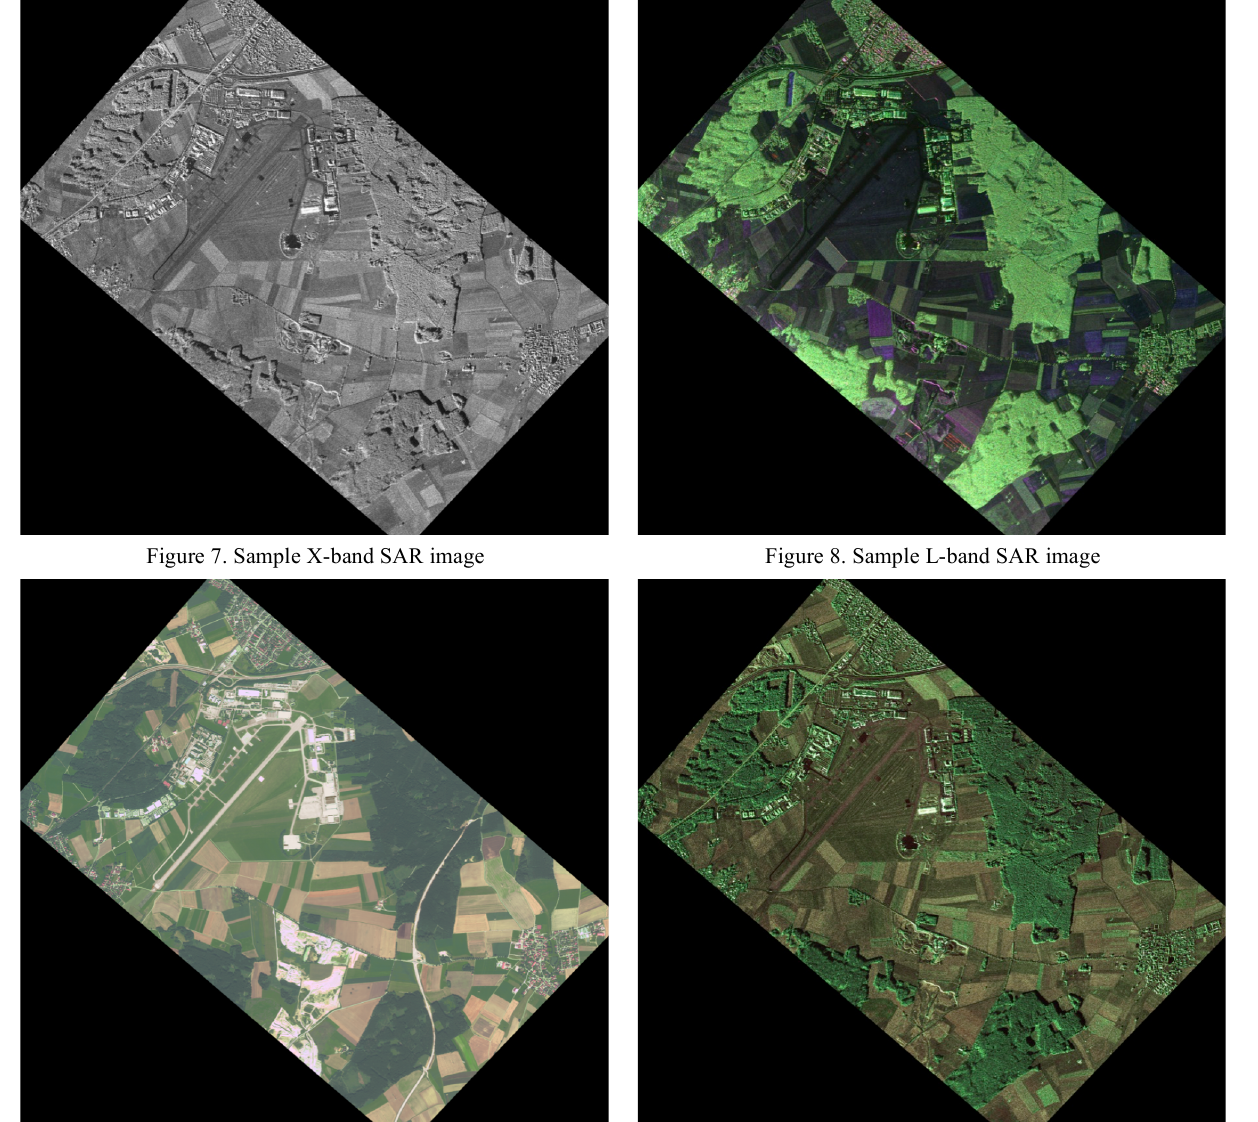
Figure 9. Sample Multispectral Optical image Figure 10. Sample Fused